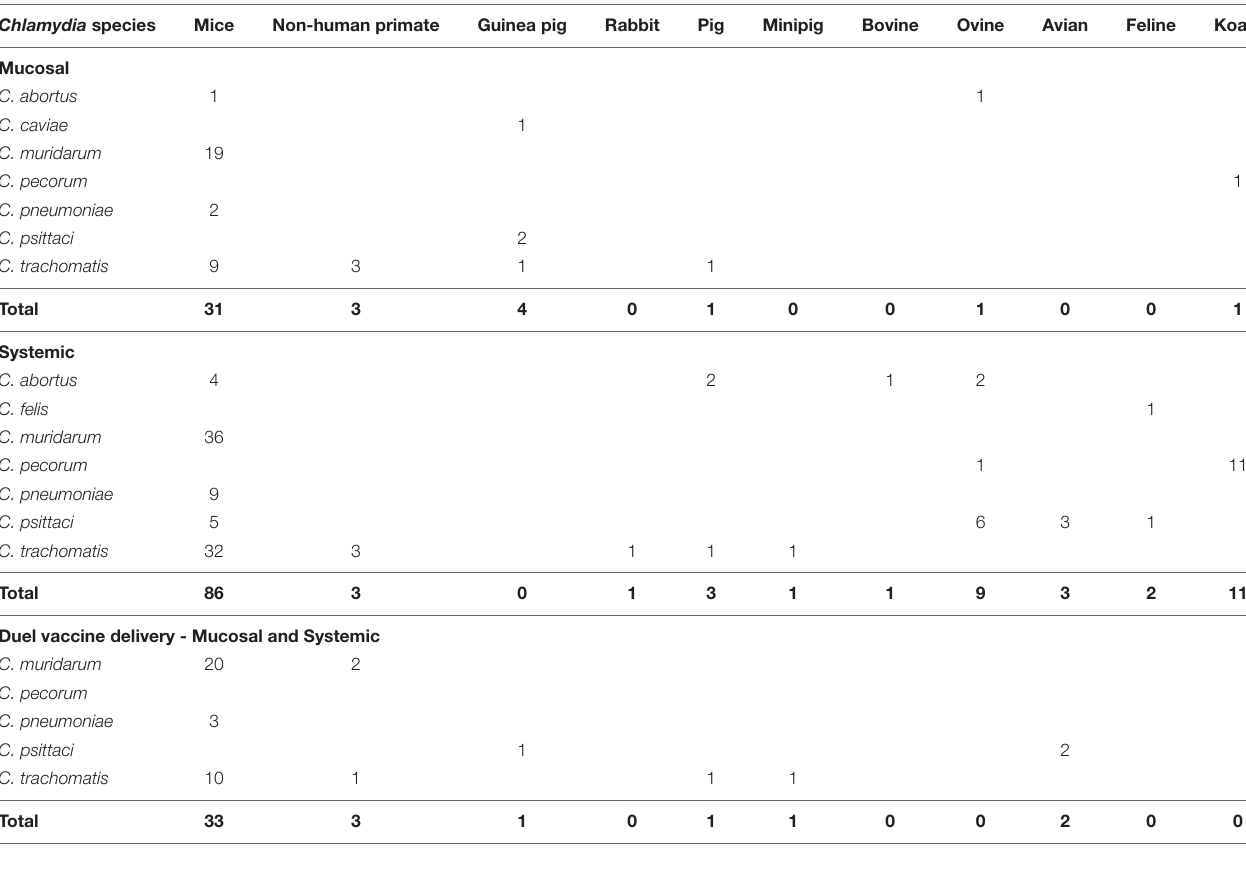
TABLE 4 | Site for vaccine delivery by chlamydial species and host. Chlamydia species Mice Non-human primate Guinea pig Rabbit Pig Minipig Bovine